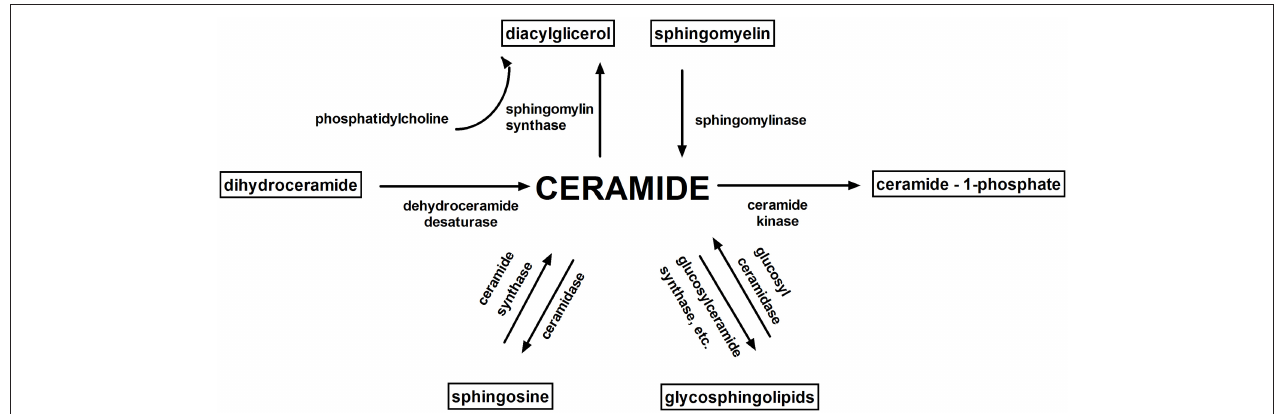
FIGURE 2 | Sphingolipid metabolism. Ceramide is a key molecule in sphingolipid metabolism. The main bioactive sphingolipids: ceramide, sphingosine, sphingosine 1-phosphate, ceramide-1-phosphate play an important role in cell signaling.